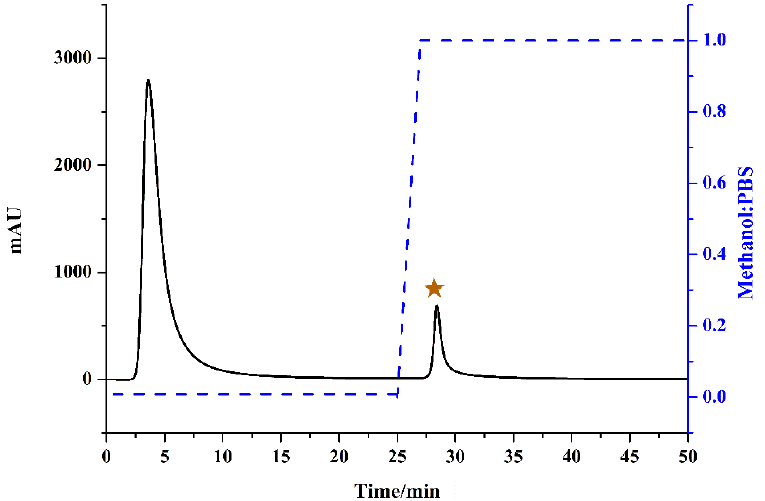
Figure 3. Chromatogram (black line) and concentration ratio of methanol and PBS (blue line) on the affinity solid-phase extraction column for Fr-3 of P. hookeri. The chromatographic conditions: eluent A: PBS, B: methanol; gradient: 0–25 min, 100% A; 25–27 min, 100–0% A; 27–50 min, 100% B; flow rate: 1 mL/min; monitoring wavelength: 254 nm.